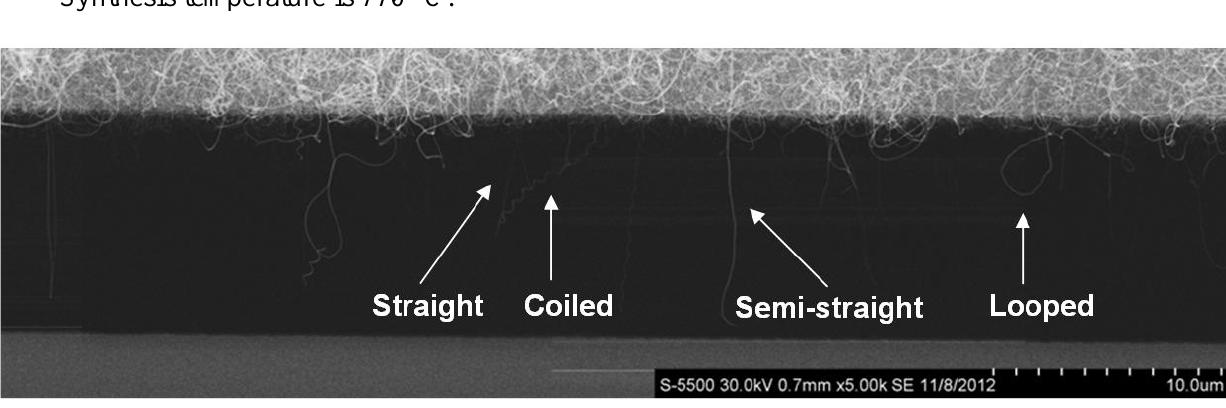
Figure 3. Collection of several SEM images showing CNTs of different shapes growing from the microheater (top) and across the gap towards the secondary microbridge (bottom). Synthesis temperature is 770 °C.